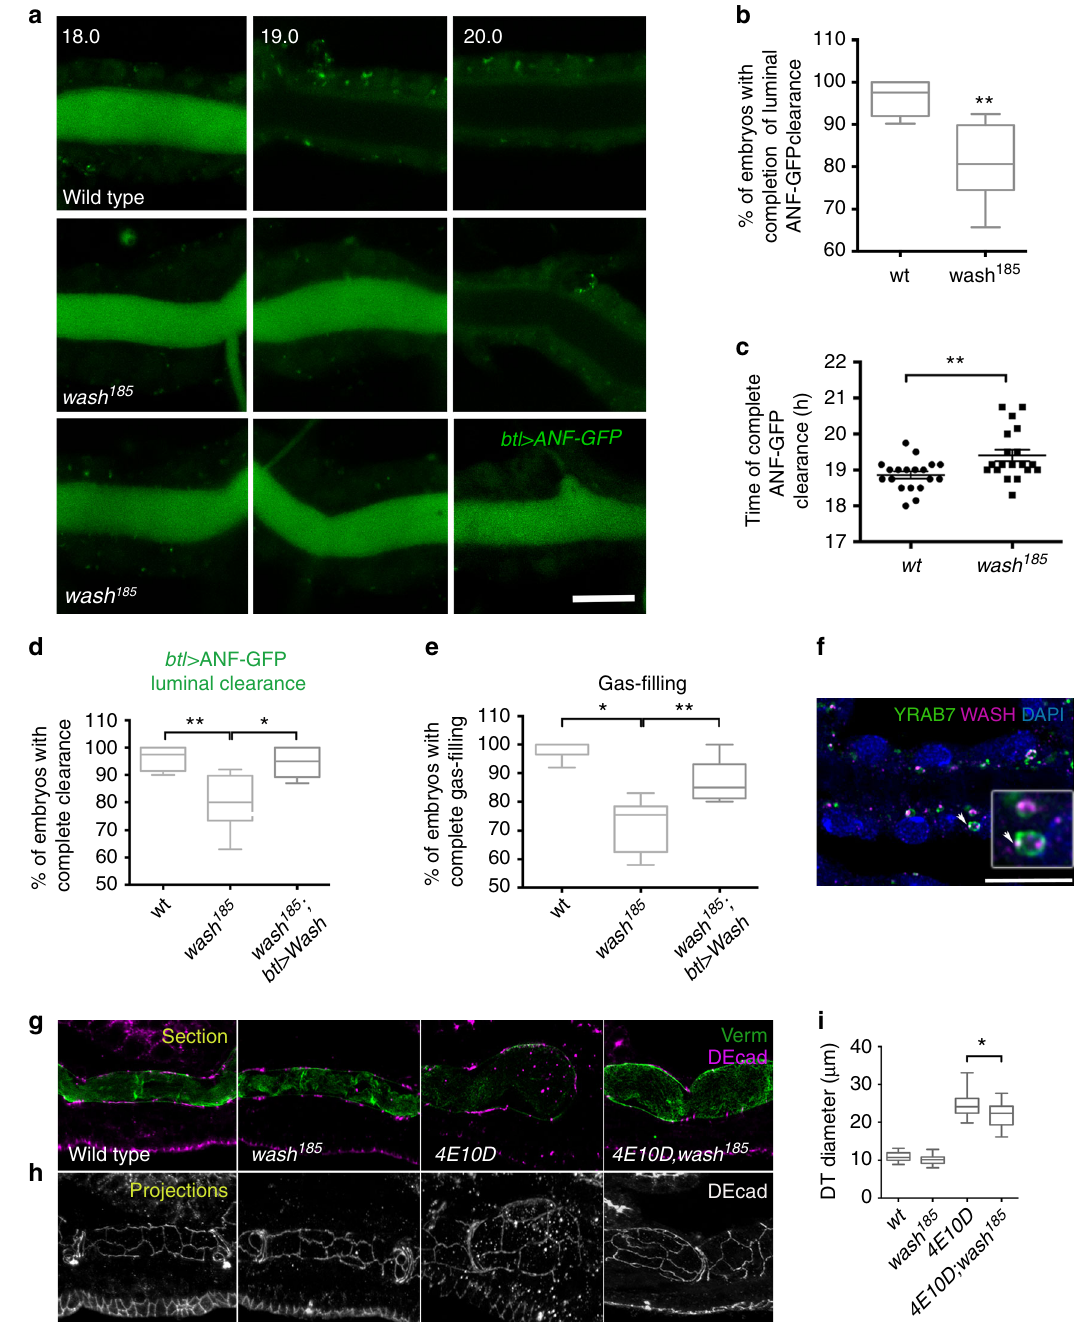
(Fig. 7f, g). Similarly, Drosophila wash 185 mutant